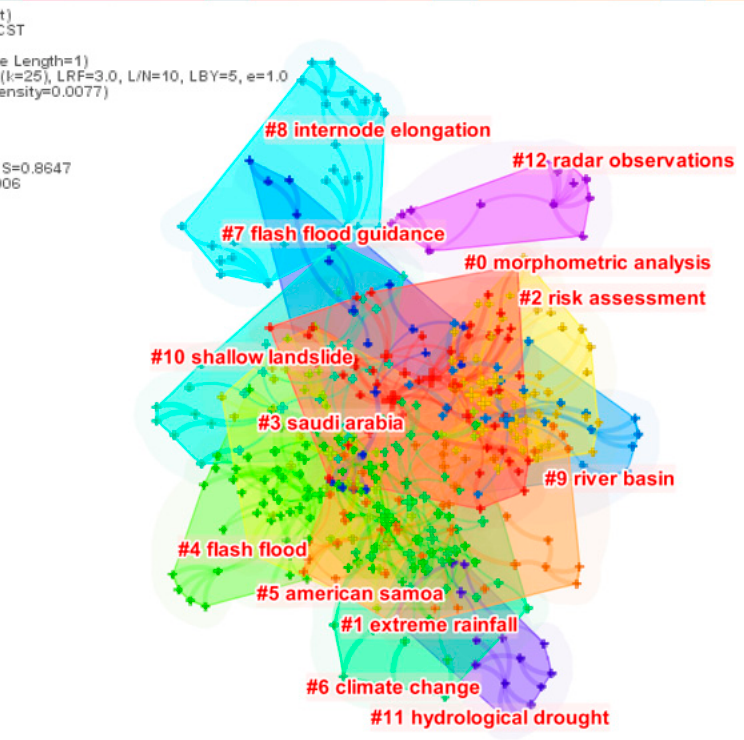
Figure 12. Cluster analysis of research hotspots (based on keyword analysis).